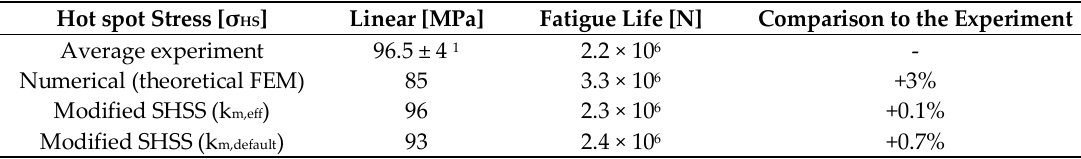
Table 2. Summary of the